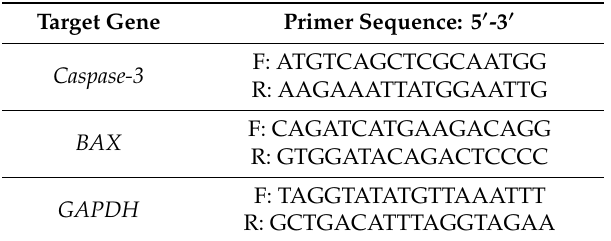
Table 3. Primers sequence and annealing temperature specific for each